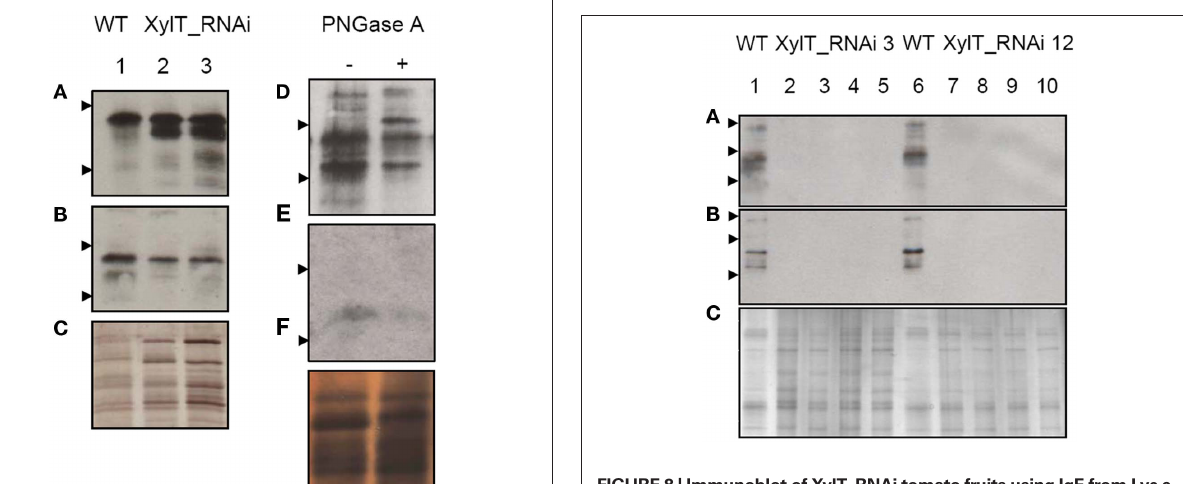
FiguRe 8 | immunoblot of XylT_RNAi tomato fruits using ige from Lyc e 2-sensitized patients. IgE-binding to soluble protein extracts from red tomato fruits harvested from L. esculentum cv. MicroTom wild type (WT, lanes 1 and 6), XylT_RNAi line 3 (lanes 2–5), XylT_RNAi 12 (lanes 7–10). (A) IgE-binding using serum from patient 7241–7, (B) IgE-binding using serum from patient 8695–24. Fruits analyzed were derived from the T1-generation of transgenic plants. Lane 2, XylT_RNAi 3–1; lane 3, XylT_RNAi 3–7; lane 4, XylT_RNAi 3–10; lane 5, XylT_RNAi 3–16; lane 7, WT; lane 8, XylT_RNAi 12–3; lane 9,